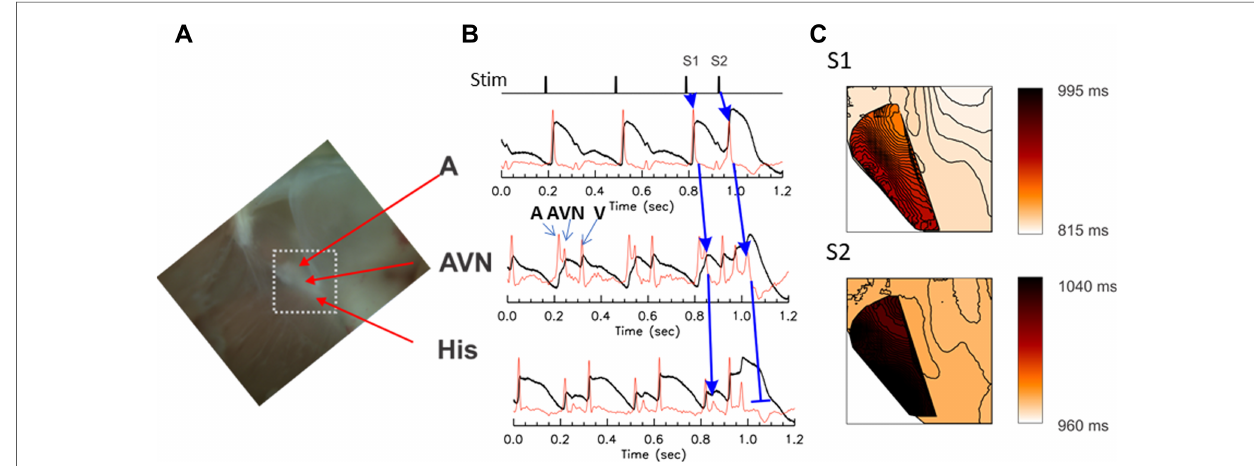
FIGURE 1 Optical mapping of conduction delay through the AV node. The AV node is a three-dimensional structure consisting of multiple layers of myocytes with different electrical properties and delays in fi ring; as a result, three distinct upstrokes are detected from each pixel, in the optical voltage-recordings from the AV node region. ( A ) A photo of the Triangle of Koch. The mapped area is marked with a white dotted box (5 s mm×5 s mm). ( B ) Representative optical mapping traces recorded from the AVN region of a rabbit heart under S1 – S2 stimulation protocol. The fi rst derivative (red traces) shows three distinct upstrokes associated with atrial (A), nodal/His (AVN, blue arrows), and ventricular (V) AP. The atrial tissue was paced at S1 – S2 (basic CL=300 ms followed by S2 at 140 ms). The upstroke of the AVN AP appeared substantially later in the S2 beat than the S1 beat (see the middle trace) and propagated toward His-bundle with a diminishing magnitude of the AP upstroke compared tothe S1 beat (blue arrows for S2 beat), indicating decremental conduction. ( C ) Activation maps of atrial and nodal-His upstrokes. The atrial and nodal upstrokes were mapped separately, then are superimposed to visualize the overlap of the atrial and nodal tissues. Isochronal lines are drawn every 1 ms interval. The conduction velocity of AVN propagation of control beat was 0.101 mm/ms while the conduction of premature S2 beat in the AV node was slightly slower (0.08 mm/ms) and died out in the His bundle, in this example. A movie of AV nodal conduction of sinus beat, and S1 and S2 beats are provided as the Supplementary Material respectively as Supplementary Movies S1, S2